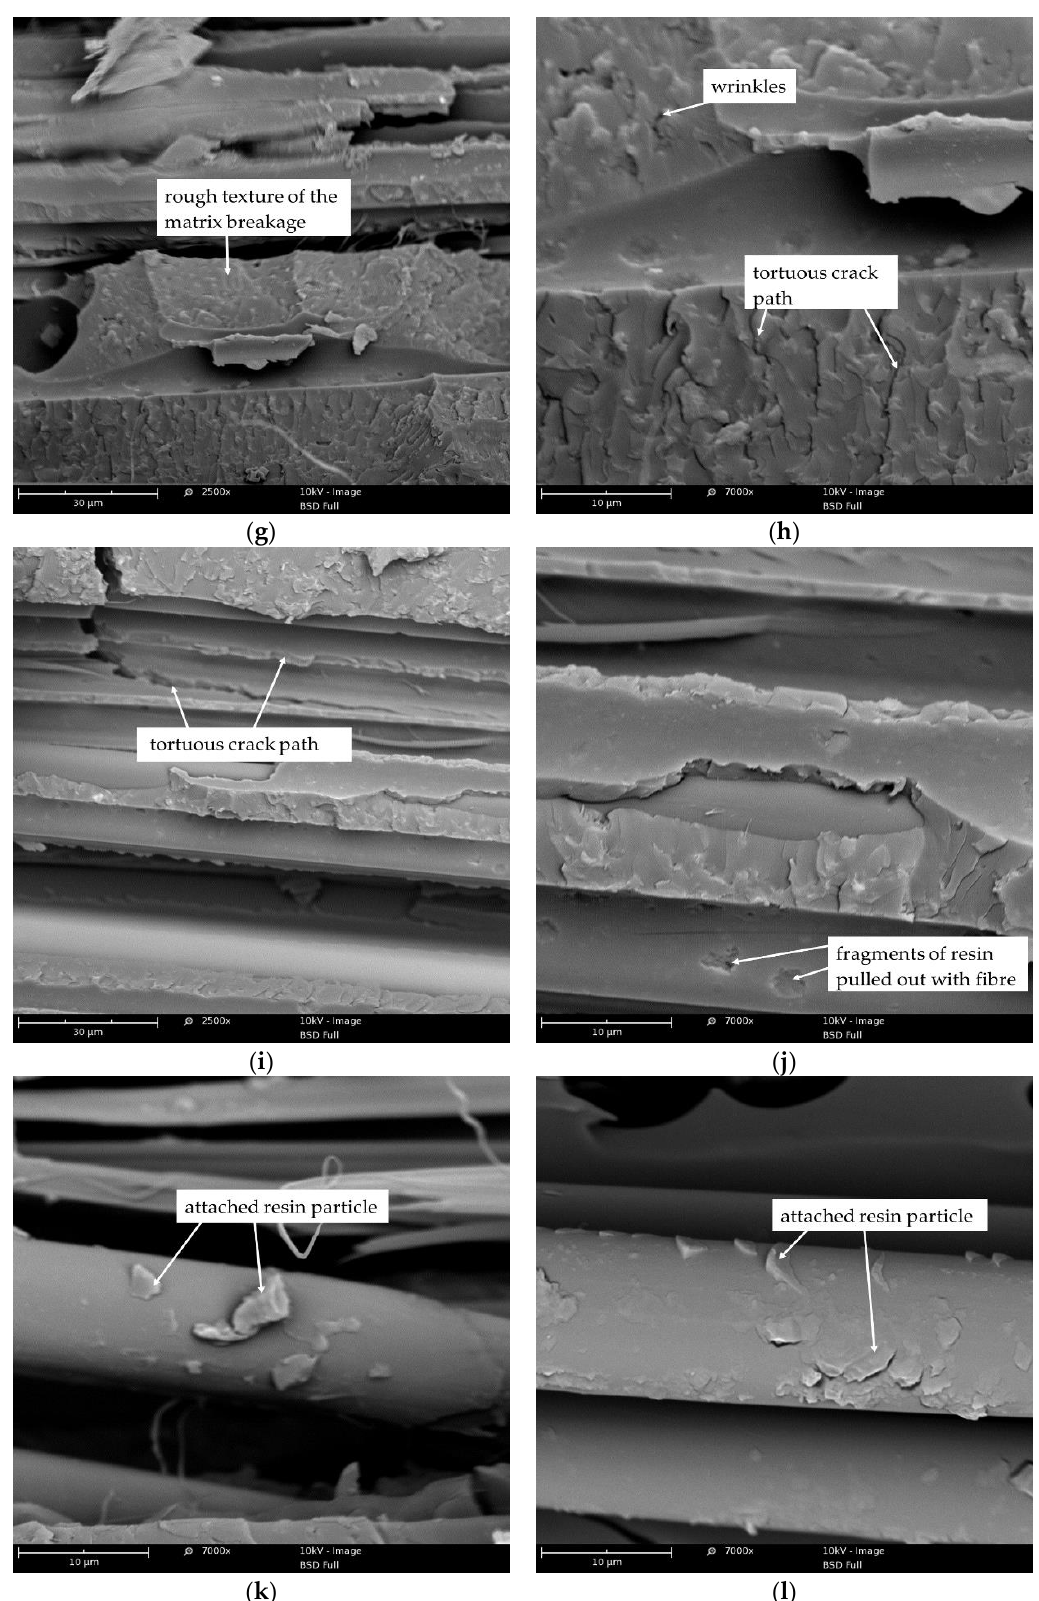
Figure 14. Scanning Electron Microscopy (SEM) microphotographs of brittle fractures of Kevlar-reinforced composites with matrices: EP ( a , b ), EP+1%BAQAS ( c , d ), EP+1%BAQPS ( e , f ), EP+3%BAQAS ( g , h , k ), EP+3%BAQPS ( i , j , l ).